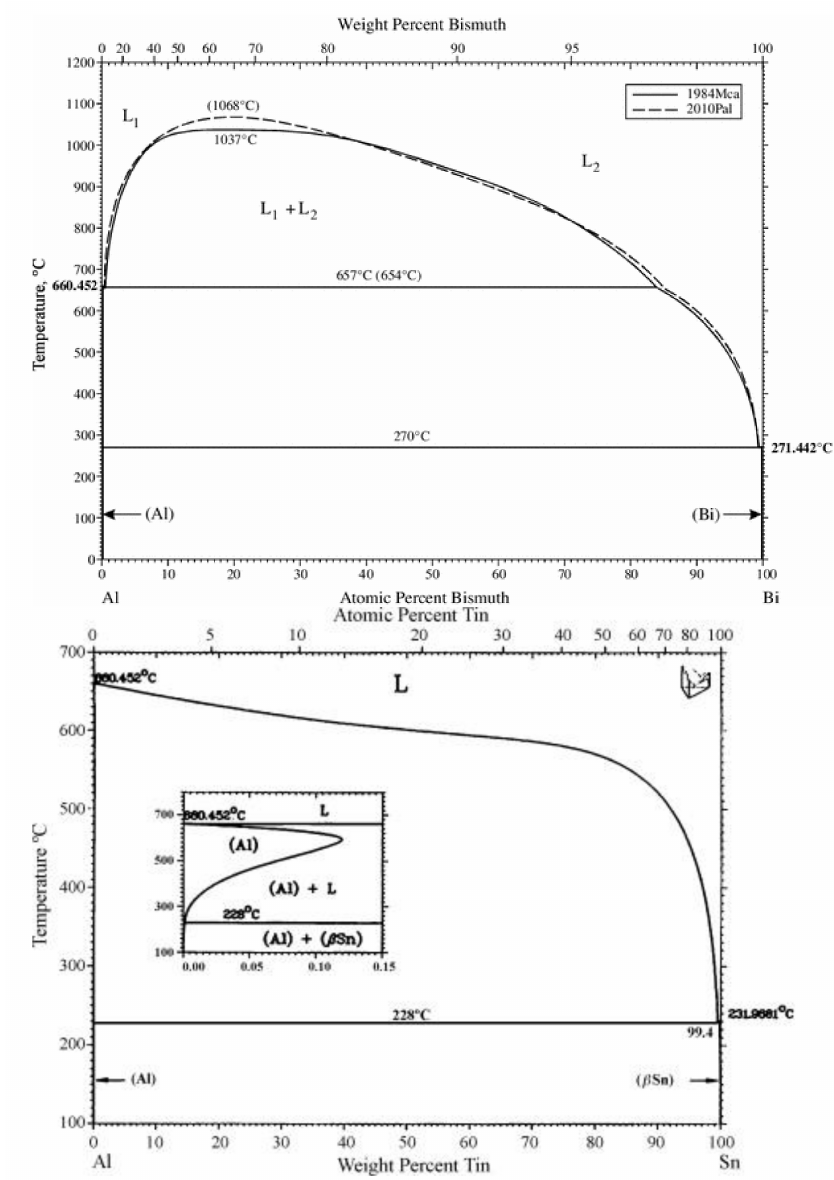
Figure 1. Bi-Sn, Al-Bi, Al-Sn phase diagrams [28].